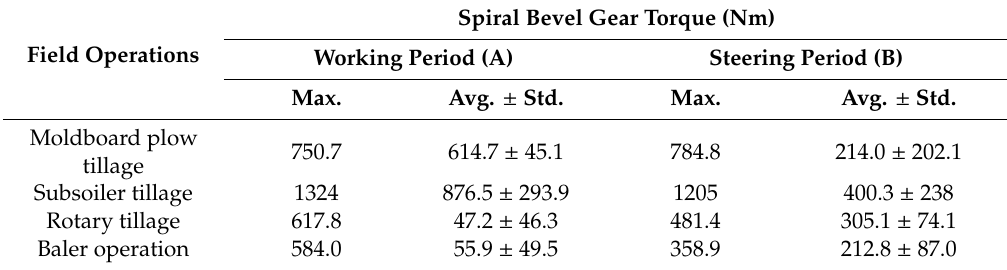
Figure 7. Dynamic load profile of spiral bevel gear by field operations: ( a ) moldboard plow tillage, Table 6. Statistical description of the spiral bevel gear torque by field operations during working and steering periods.